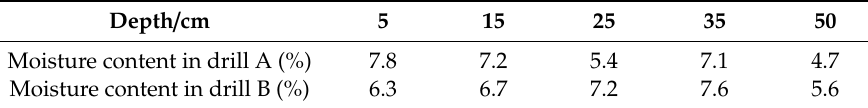
Figure 6. Depth profiles of water content in a sand layer in the leeward slope in the central part of the megadune to the west of Huhejaran Lake. (Water content more than 3.5% in sand is gravity water and water content less than 3.5% in sand is absorbed water). Table 2. Moisture content in multi-stage fans in the megadune of eastern Zhalate Lake.